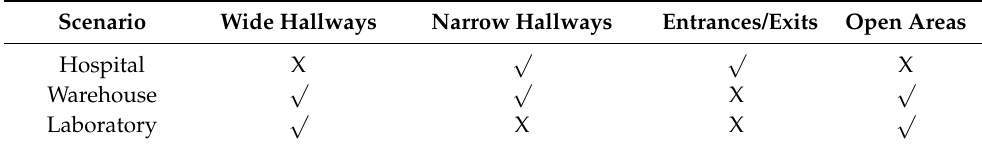
Table 1. Differences among the three